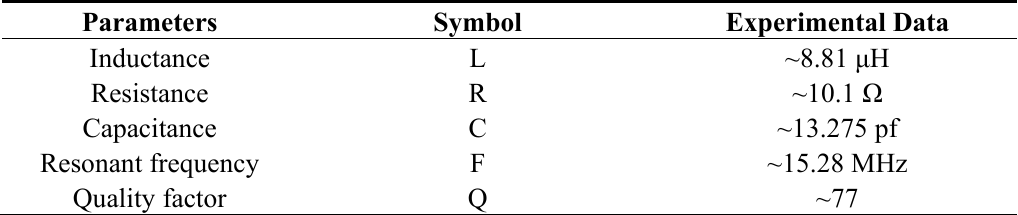
Table 3. Electrical parameters of the